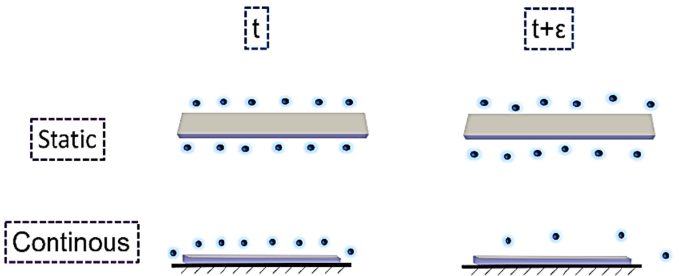
Figure 3. Gradient of concentration at t and t + ε for the static and continuous flow.